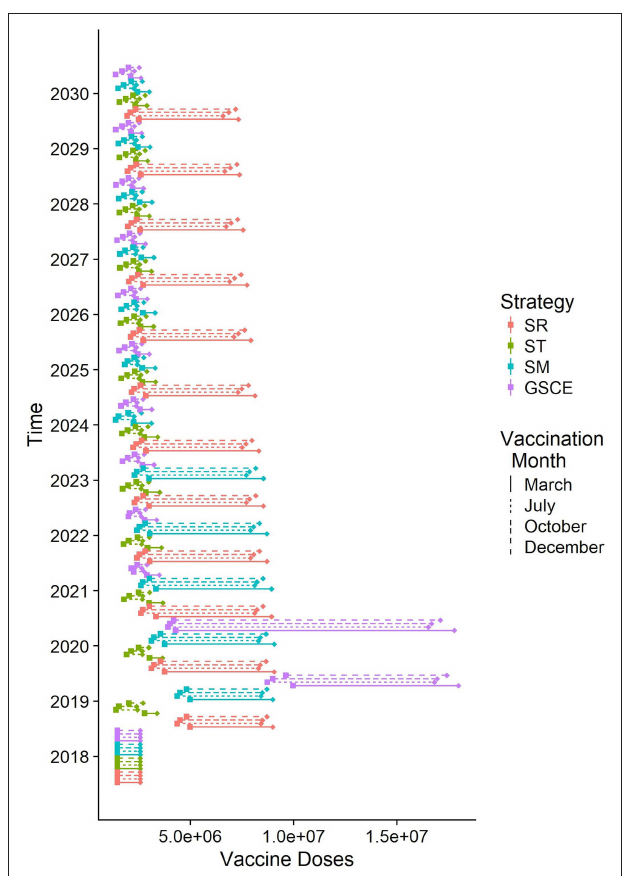
FIGURE 7 | Quantity of vaccine distributed each year according to different strategies (median). For each line, on the right the total number of doses distributed, on the left the effective doses given to susceptible individuals. The length of the rod corresponds to the number of doses wasted because given to already infected